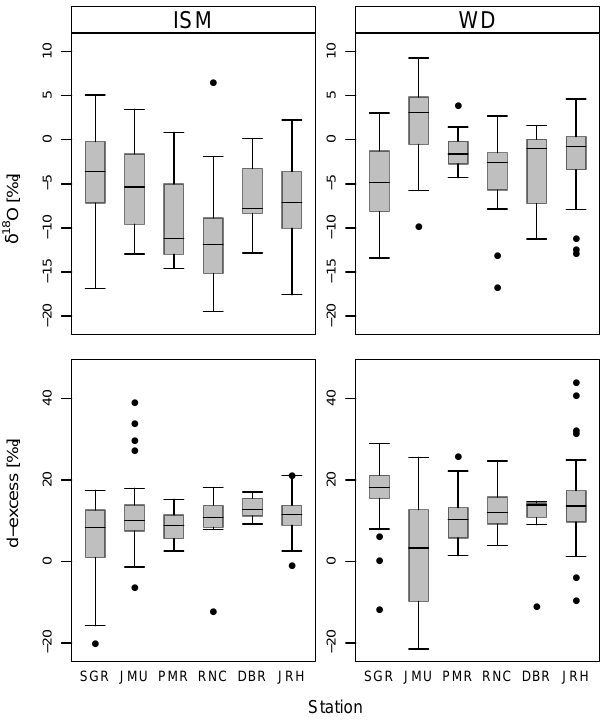
Figure 5. Box and whisker plots for δ 18 O and d -excess values of daily rainfall at the six stations (Srinagar – SGR; Jammu – JMU; Palampur – PMR; Ranichauri – RNC; Jorhat – JRH; and Dibrugarh – DBR) collecting daily rainfall samples along southern foothills of the Himalayas (cf. Fig. 1). The data are grouped into Indian summer monsoon (ISM) and western disturbances (WD) periods.